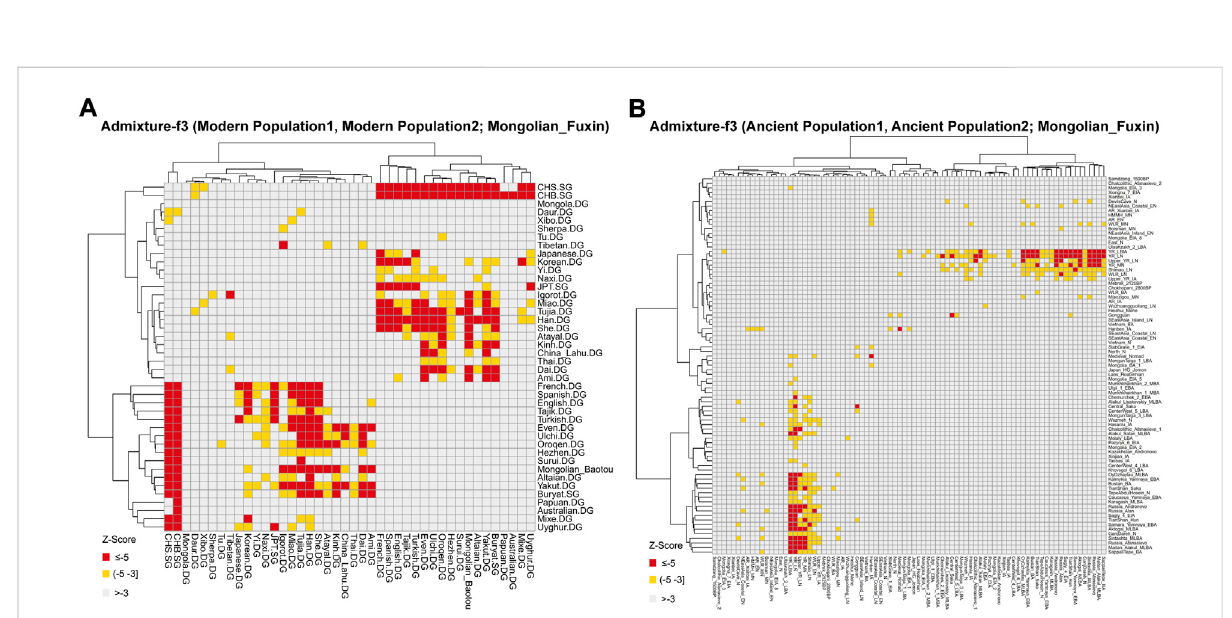
FIGURE 6 Heatmap of the admixture f 3 -statistics of the form f 3 (X, Y; Mongolian_Fuxin). The red and yellow color indicated signi fi cant admixture signals, and X and Y were the possible ancestral contributors of Fuxin Mongolians. (A) Admixture- f 3 (Modern population1, Modern population2; Mongolian_Fuxin). (B) Admixture- f 3 (Ancient population1, Ancient population2;